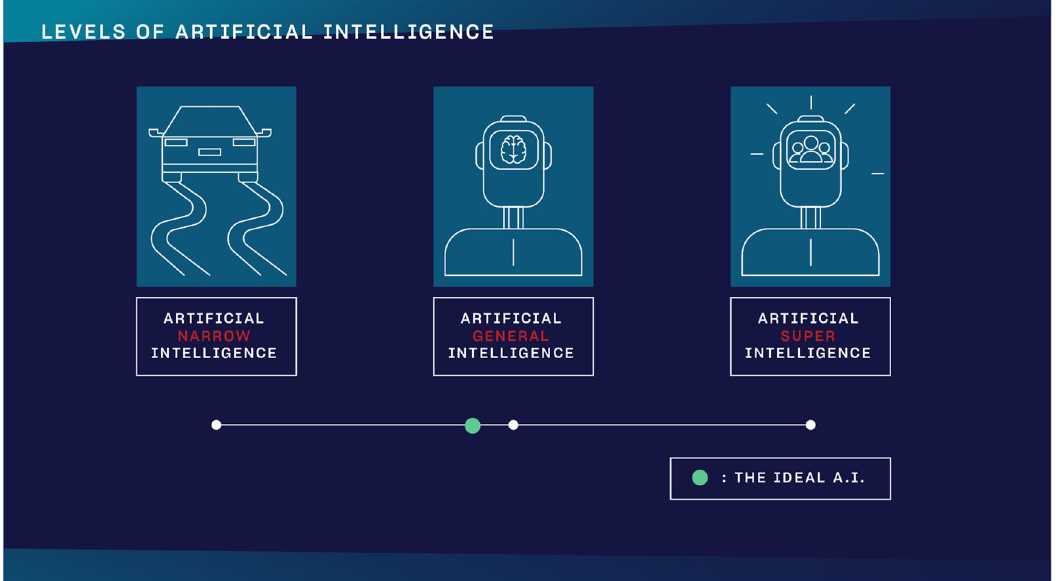
Fig. 2 Levels of A.I. The three levels of A.I. as de fi ned by Nick Bostrom in Superintelligence. The green dot indicates a theoretical threshold for what the ideal scenario would